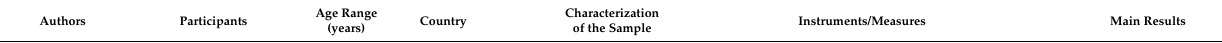
Table 1. Main characteristics and findings of the studies included in this scoping